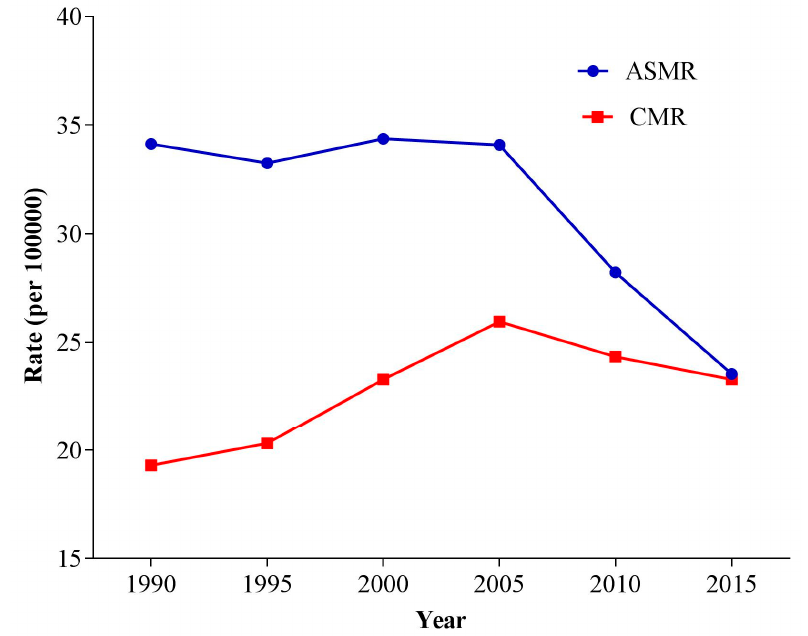
Figure 1. Trends of the crude mortality rates (CMRs) and age-standardized mortality rates (ASMRs) for stroke attributable to PM 2.5 from 1990–2015.